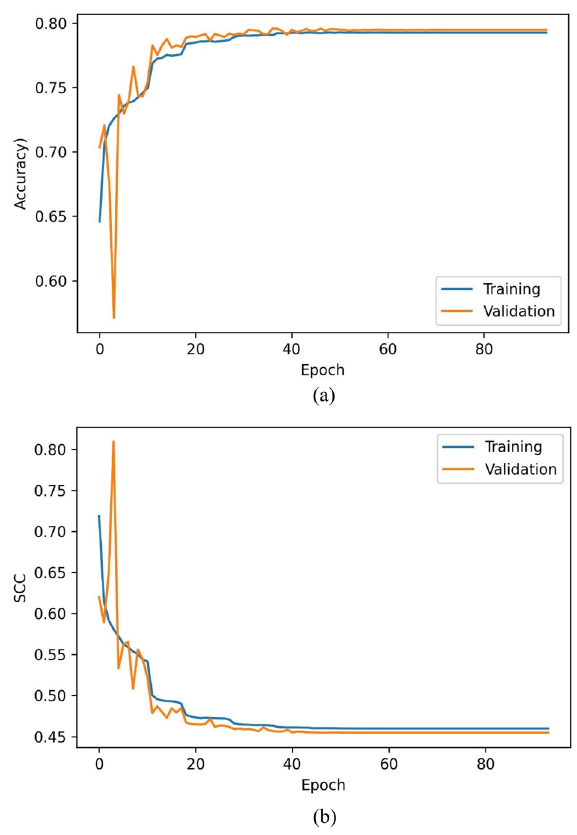
Figure 5. Training ( a ) accuracy and ( b ) SCC of ANN